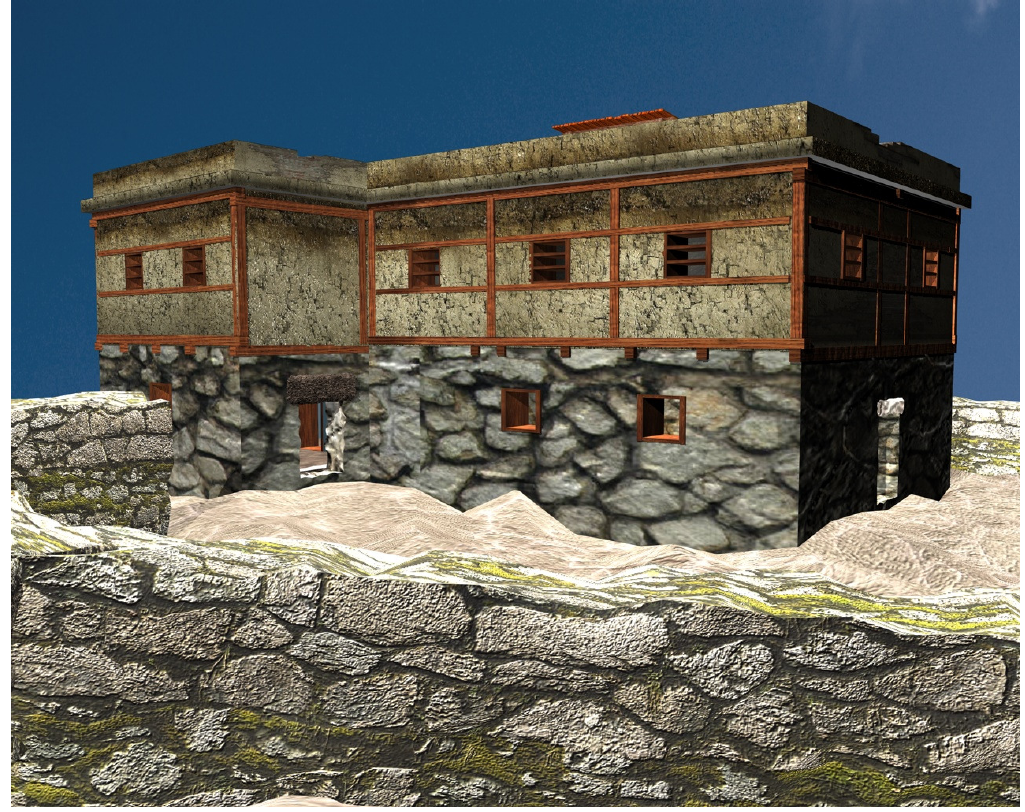
Figure 7. 3D reconstruction of Building I, set into the software-modified terrain, view from the southwest. Created in Cinema 4D.